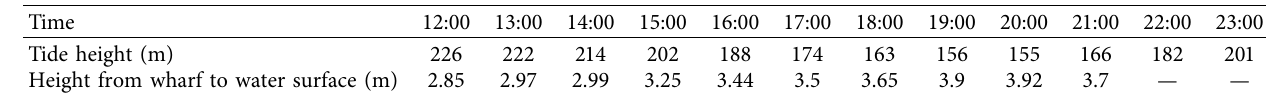
Table 9: Tide report (from 12:00 to